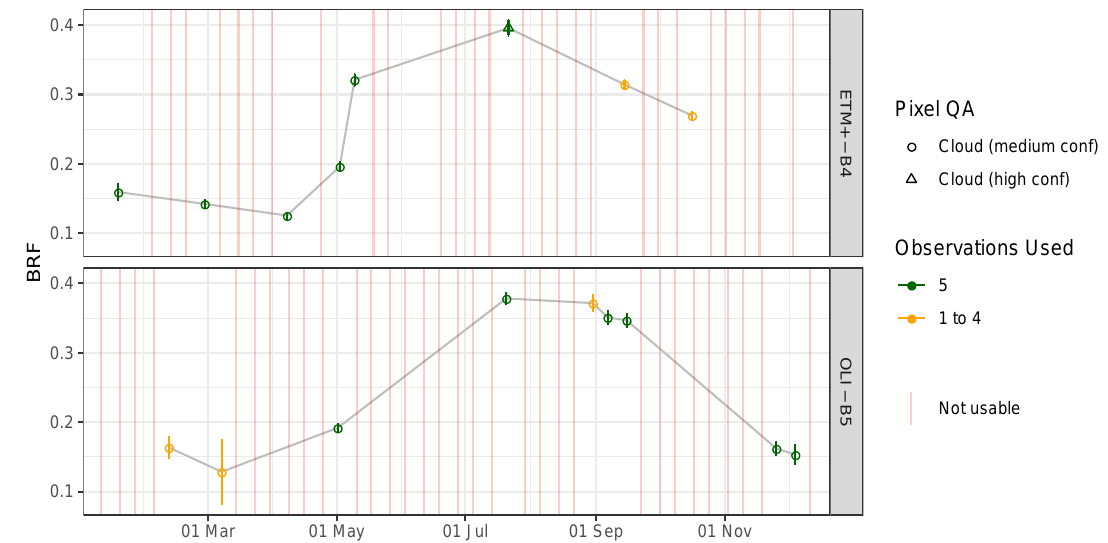
Figure 3. Observed BRFs for Landsat 7 ETM+ and Landsat 8 OLI MSI NIR bands over the year 2016 for the five Speulderbos plots (see Figure 1). Points represent average BRF over the five sites, error bars one standard deviation. Colour codes the number of plots for which the observations were useful (clear sky). Pixel QA refers to the pixel quality bits. Six observations were discarded because they exceeded a reflectance of 1 (undetected clouds). Observations used refer to how many of the BRF of the five plots were not affected by clouds and used for